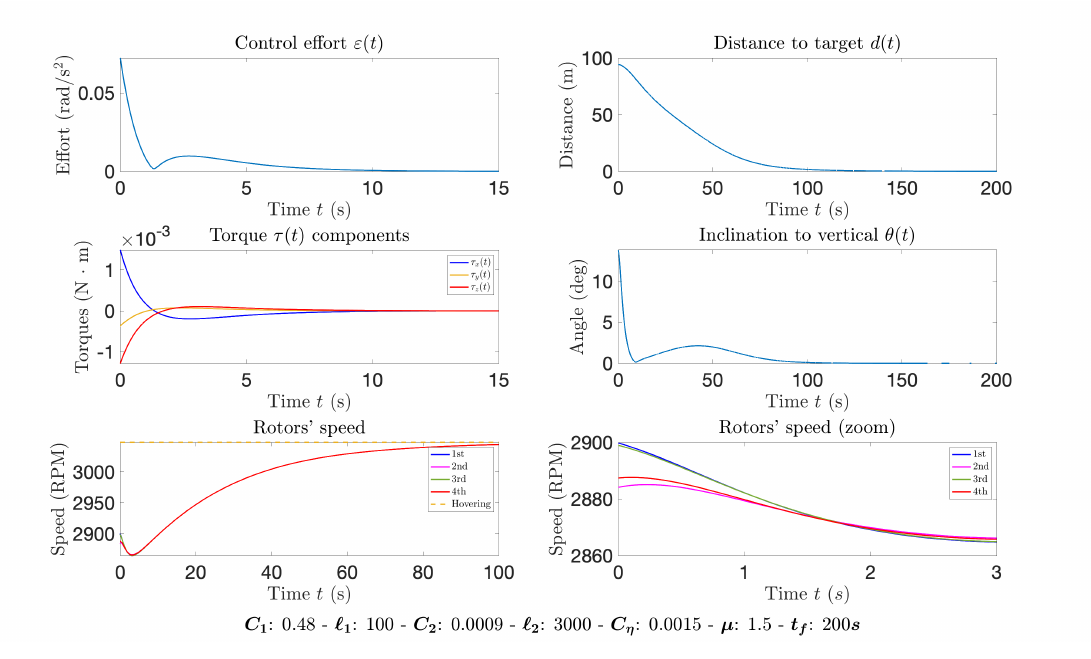
Figure 5. Experiment: Target point below the start point, random initial conditions. ( a ) Target approaching trajectory; ( b ) Control